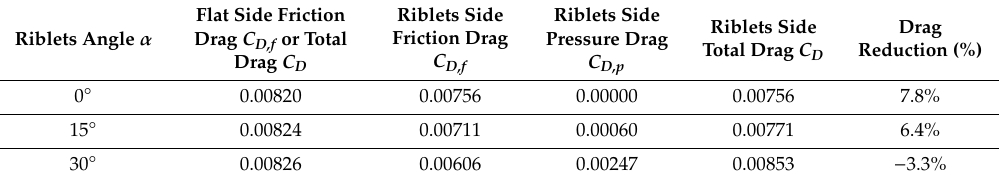
Table 1. Drag coe ffi cients of the channels with di ff erent inclined angles between the riblets and the main flow